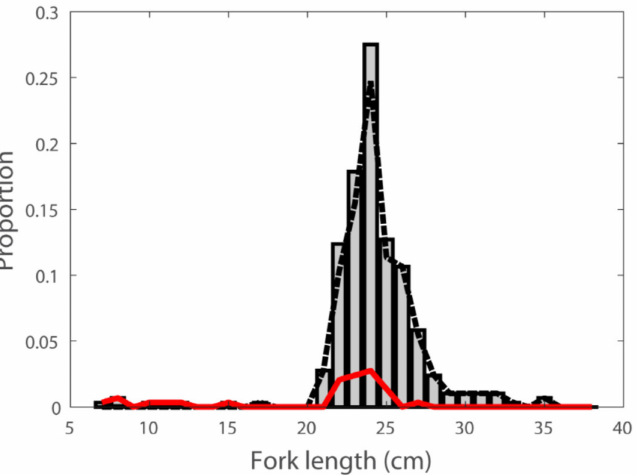
Figure 3. Pacific herring ( Clupea pallasii ) length-frequency distributions in Jinhae Bay. Gray bars represent the length-frequency distribution in the two combined surveys. The black dashed and red solid lines indicate the length-frequency distribution during January and April 2018,